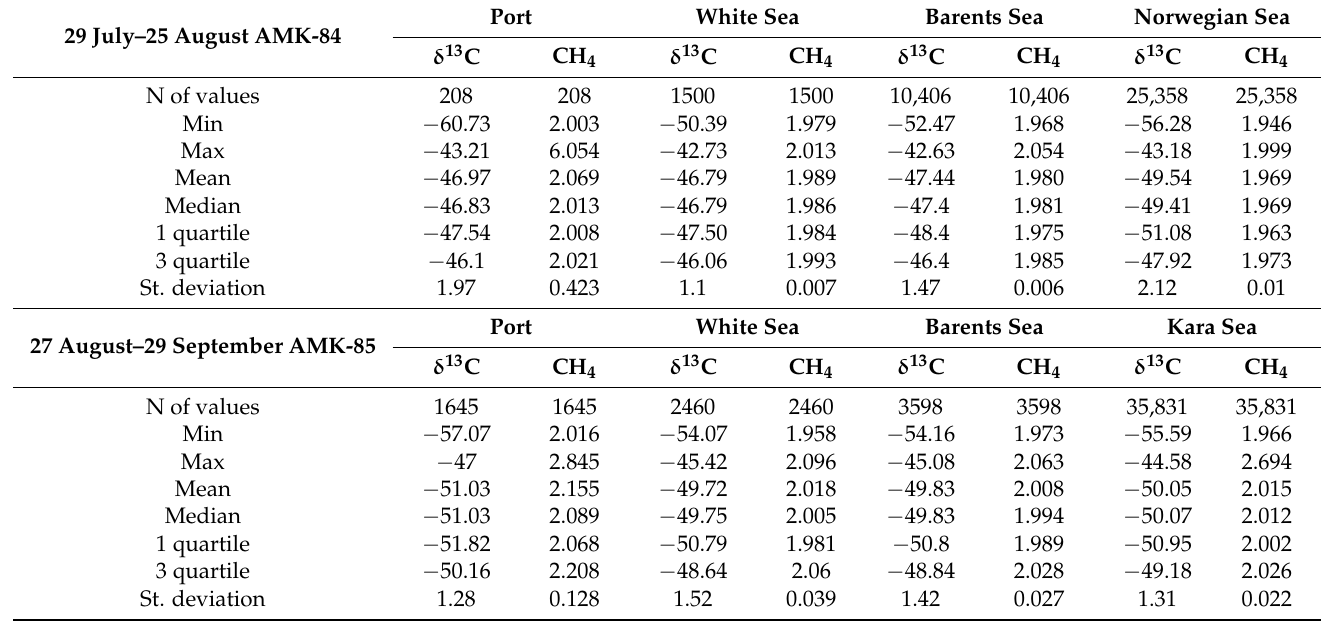
model [43,44], were analyzed for all expeditions. To build trajectories, we used GDAS meteorology 1 × 1, model vertical velocity; the end point is 500 m above sea level. Series of methane concentration with generalized transport direction were constructed (Figure